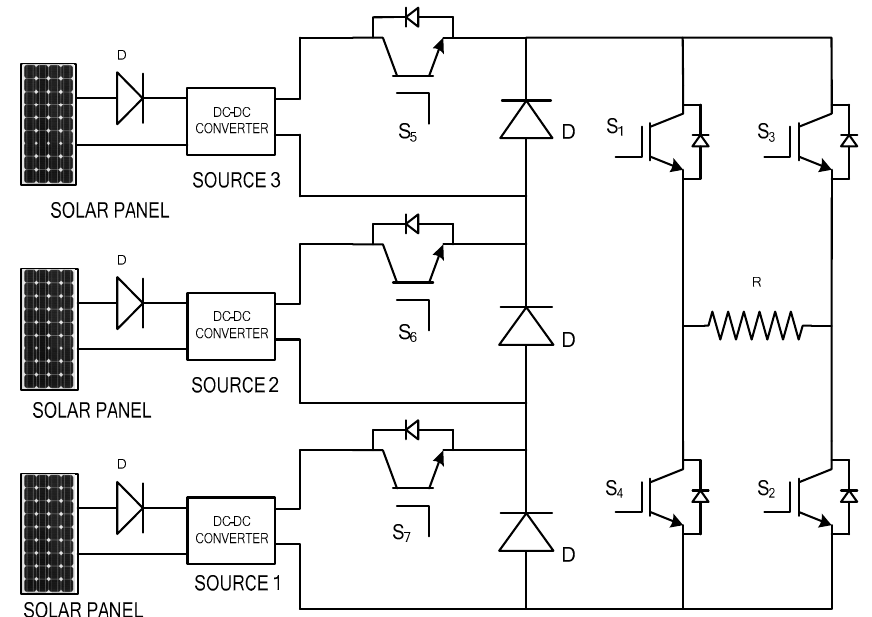
Figure 7. 15-level reduced switch multilevel inverter.